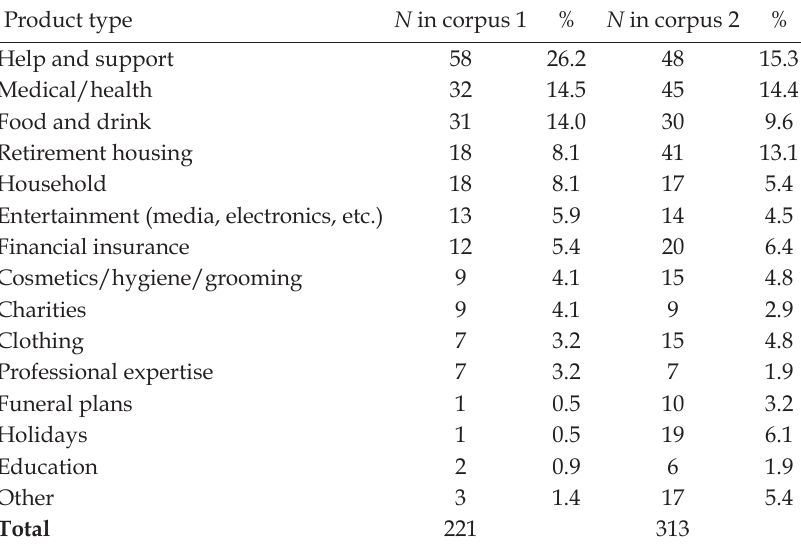
Table 2. Products associated with older models across the magazines